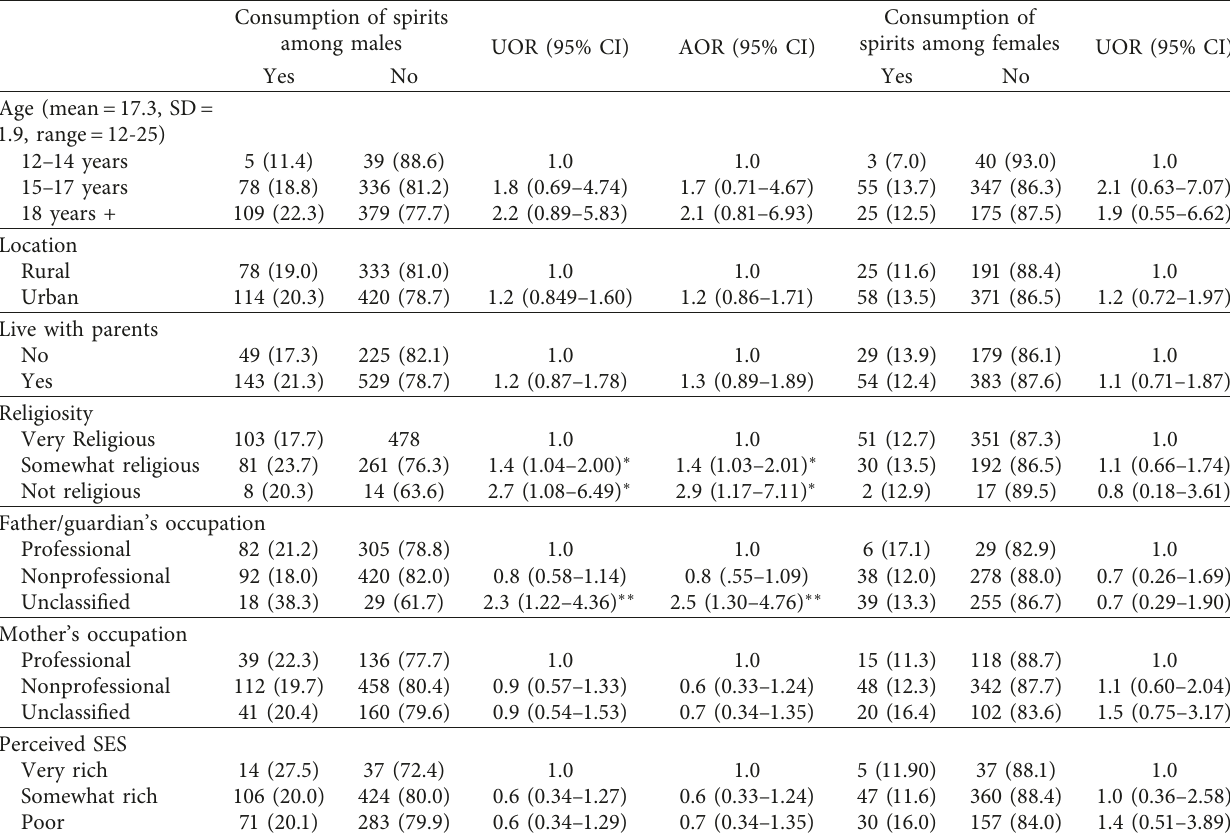
Table 2: Logistic regressions showing the association between Family factors and consumption of spirits among students. Consumption of spirits among